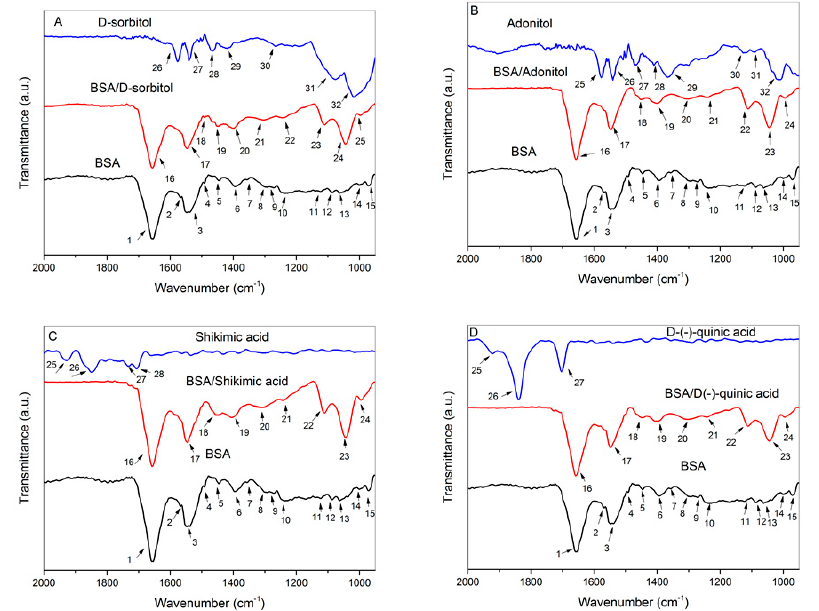
Figure 6. FTIR spectra of BSA, the cyclitols, and their complexes (at a 1:10 molar ratio) in the range of 2000–950 cm − 1 : ( A ) D-sorbitol; ( B ) adonitol; ( C ) shikimic acid; ( D ) D-(–)-quinic acid.